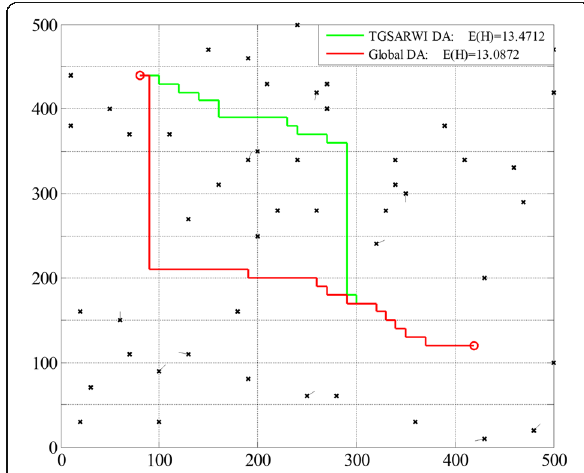
Fig. 8 An example of comparison of Global DA and TGSARWI